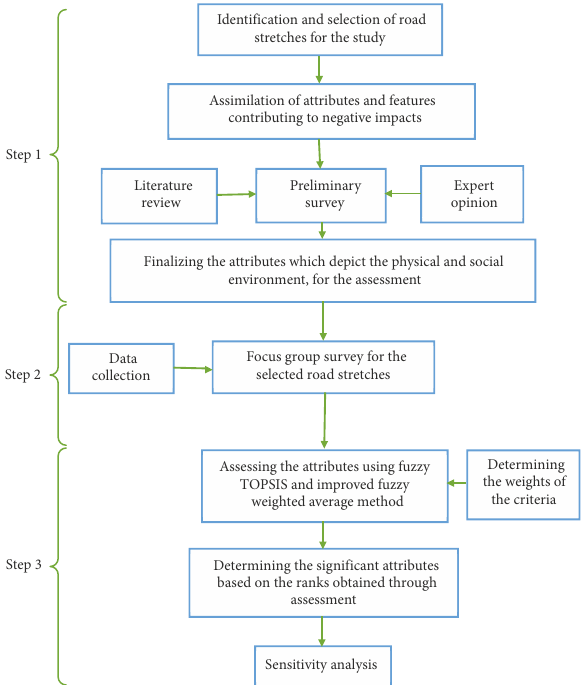
Figure 1. The methodology of the study